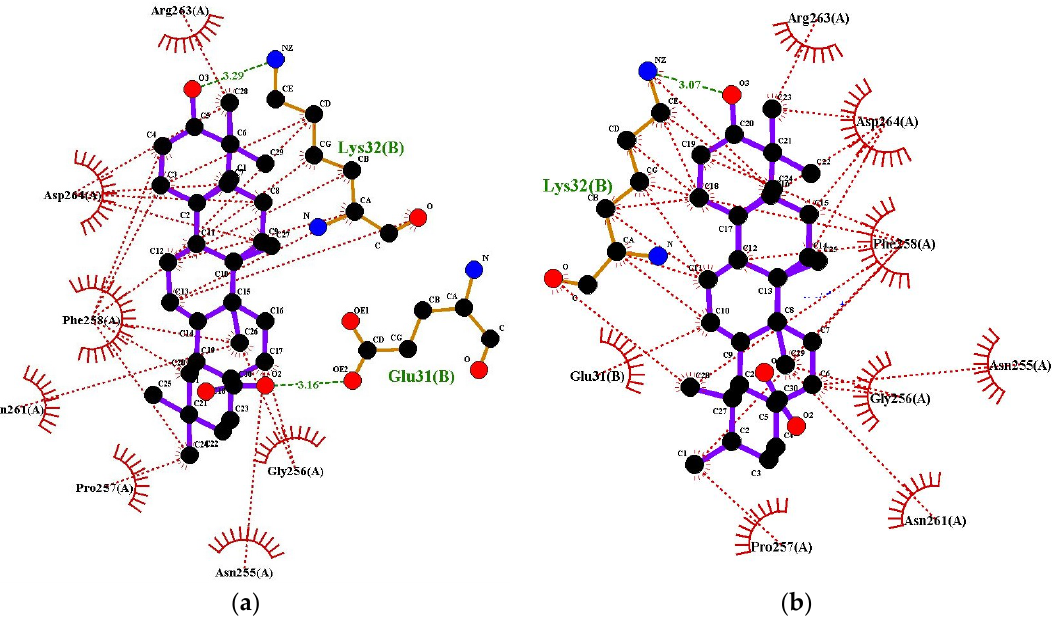
Figure 4. Ligplots showing interacting residues of Tyrosinase complex with Oleanolic Acid ( a ) and Ursolic Acid ( b ). Purple lines, triterpenes ligands; green dotted lines, hydrogen bonds labelled with distances in Å; red dotted lines, hydrophobic interactions; red circles, oxygen atoms; blue circles, nitrogen atoms.